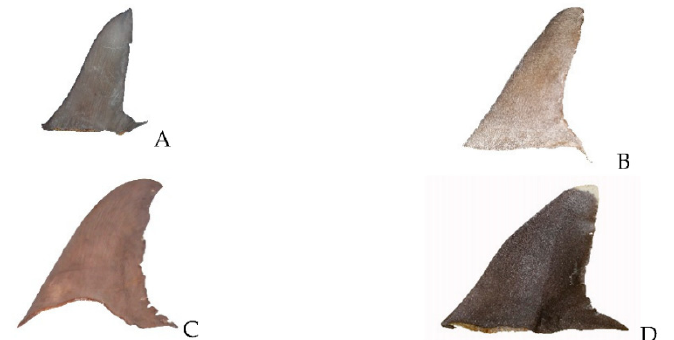
Figure 1. Dry shark fins from the first dry fin shark species up to the last dry fin shark species. ( A ) is Sphyrna lewini , ( B ) is Sphyrna zygaena , ( C ) is Carcharodon carcharias and ( D ) is Trianodon obesus . Database without noise in the